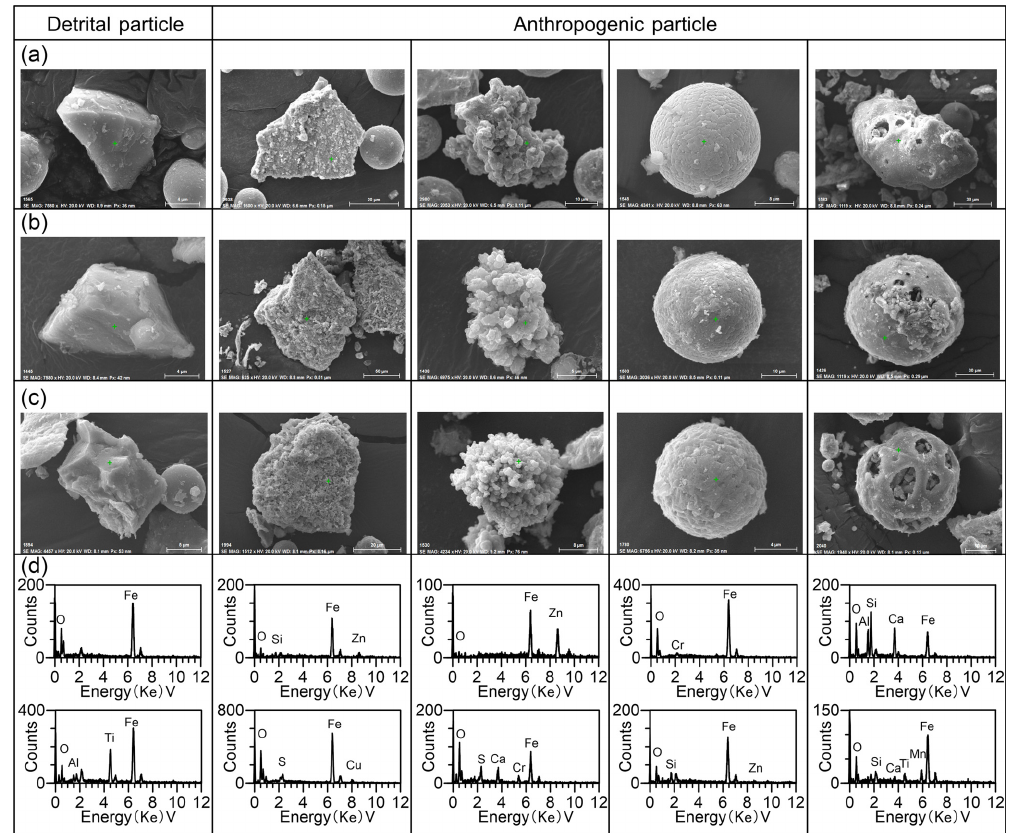
Figure 11. SEM images and typical elemental spectra (d) of magnetic extracts from street dust and (a) atmospheric dustfall with high χ lf (b) and low χ lf (c) . From left to right, the particle morphologies represent detrital particles with relatively smooth surfaces from natural source regions, anthropogenic particles with angular shapes and coarse surface textures, aggregates, spherules, and porous